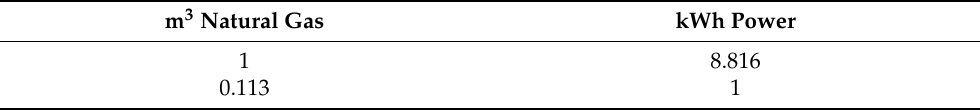
Table 3. Power-to-gas and gas-to-power convertible